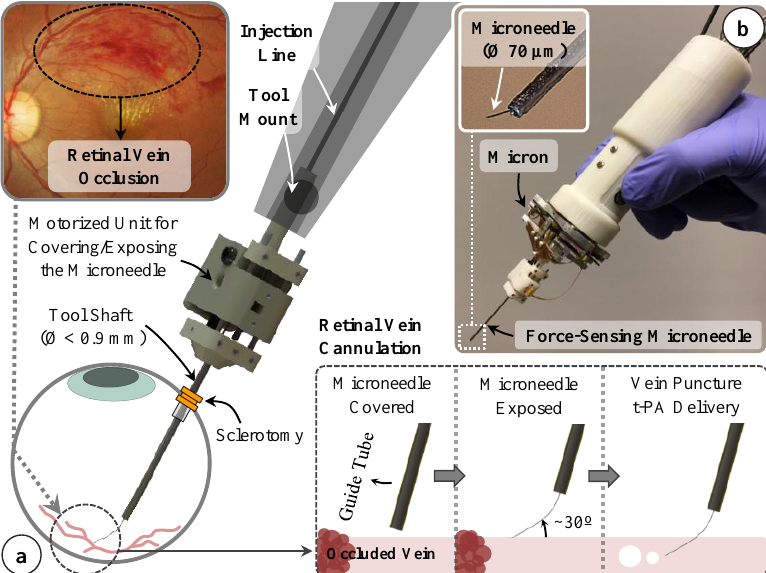
Figure 1. ( a ) Conceptual design of our motorized force-sensing microneedle for retinal vein cannulation; ( b ) The tool has a thin tip (Ø 70 µm) and a modular design that allows for easy integration with robotic devices, such as the Micron handheld micromanipulator.